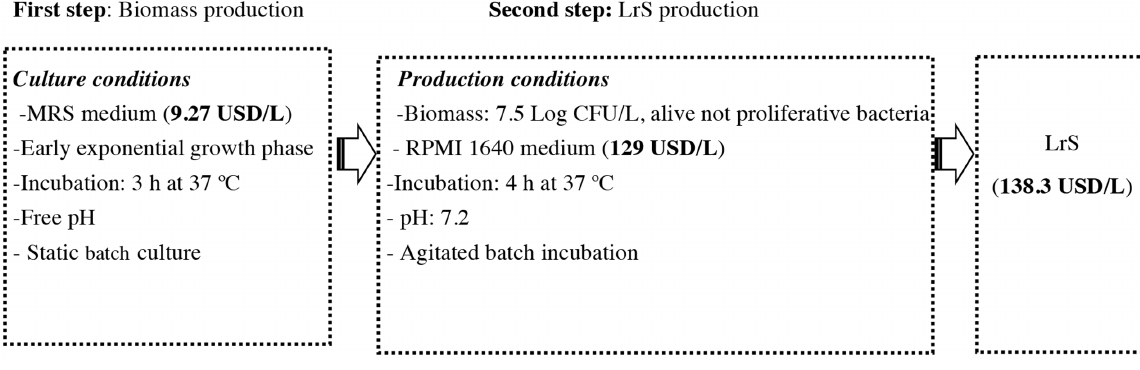
PLOS ONE | https://doi.org/10.1371/journal.pone.0200426 July 6,